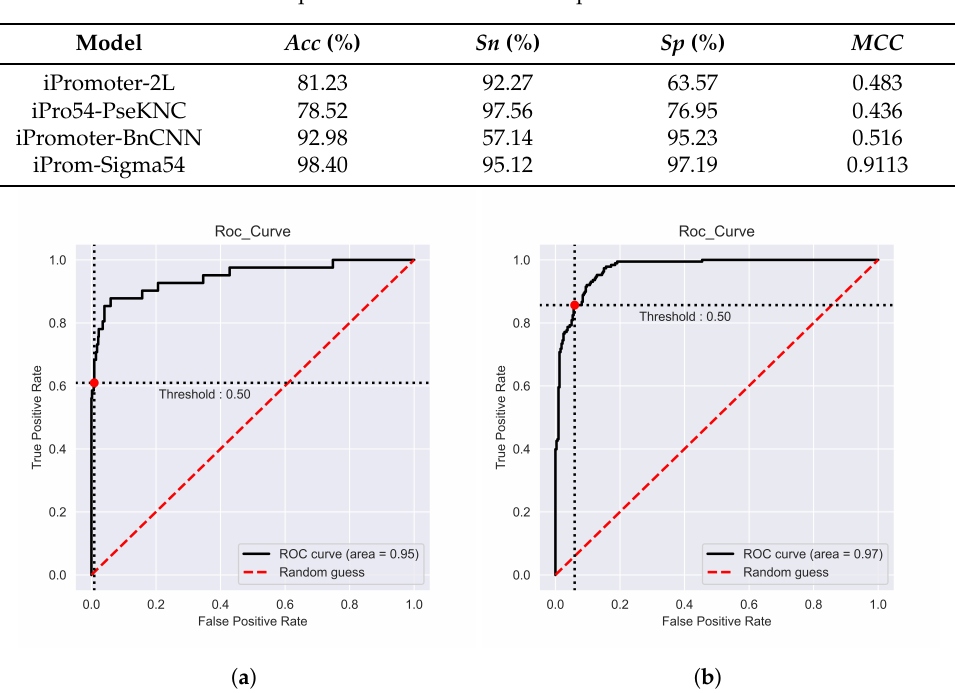
Table 4. σ 54 Promoter and non-promoter identification comparison on a test dataset.